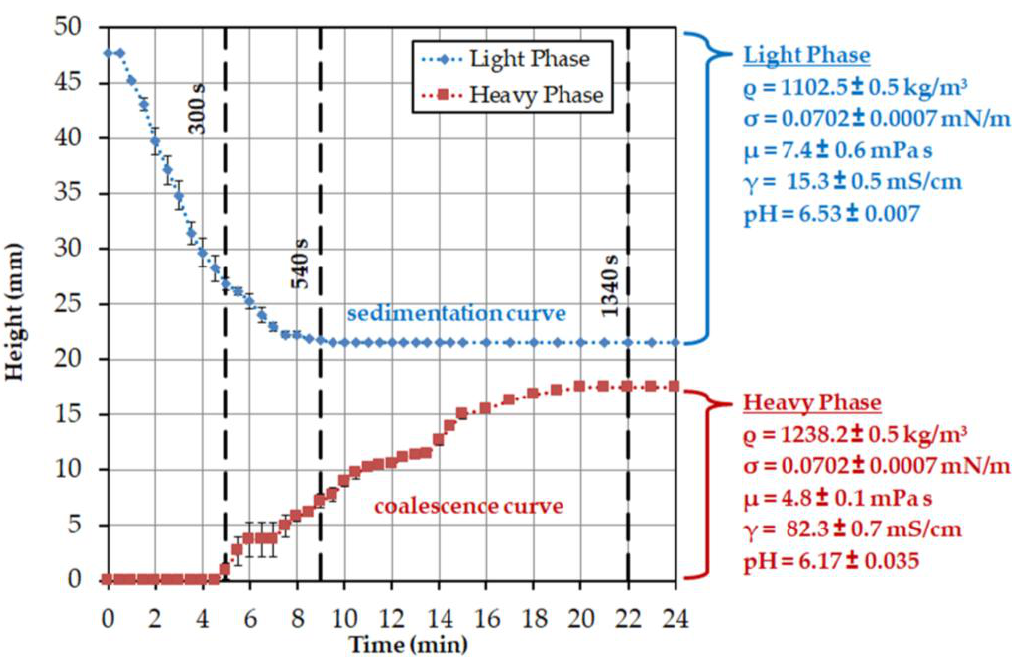
Figure 8. Marked separation times for the calculation from the settling experiments.